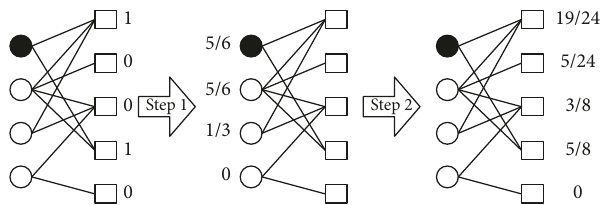
Figure 1: Standard mass diffusion algorithm at work on the bipartite user-object network. Users are shown as circles and objects are squares. The target user is indicated by the black